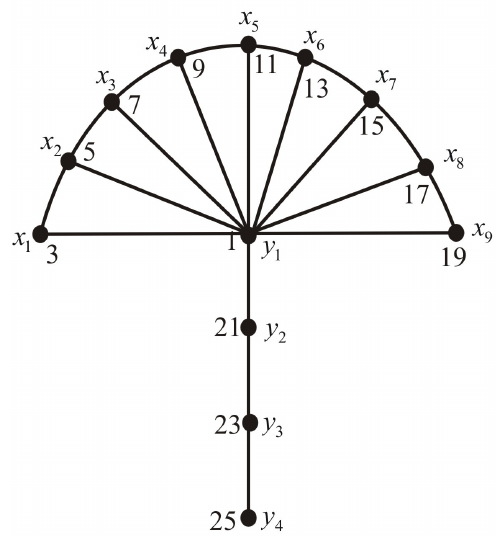
Figure 3: U ( m, n ) and its odd prime